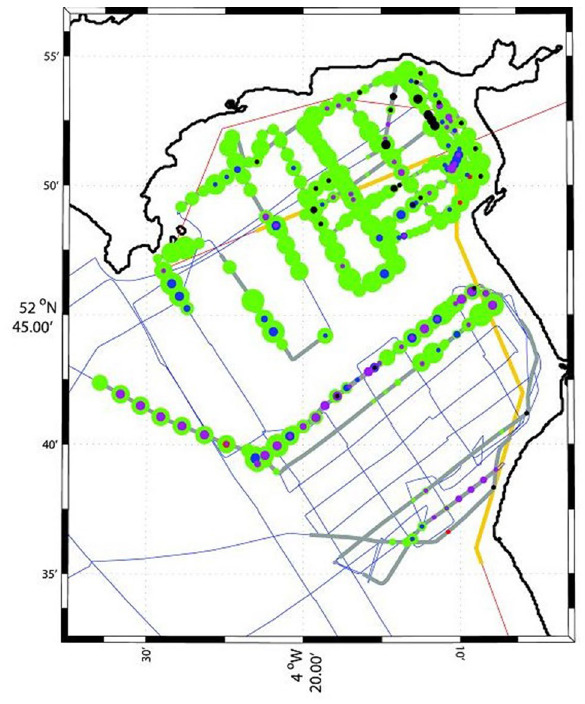
Figure 3. Jellyfish abundance sampling along the cruise route. Coloured circles are different jellyfish species: green Aurelia; red Chrysaora hysoscella ; blue Cyanea lamarckii ; purple Cyanea capillata and black Rhizostoma pulmo . The size of the circles is proportional to the log jellyfish count, varying between 0 and 9. The cruise track is given by the blue lines; observations the green line; the red line shows the aerial survey flight path, and the yellow line is a zone identified by previous aerial surveys as a jellyfish